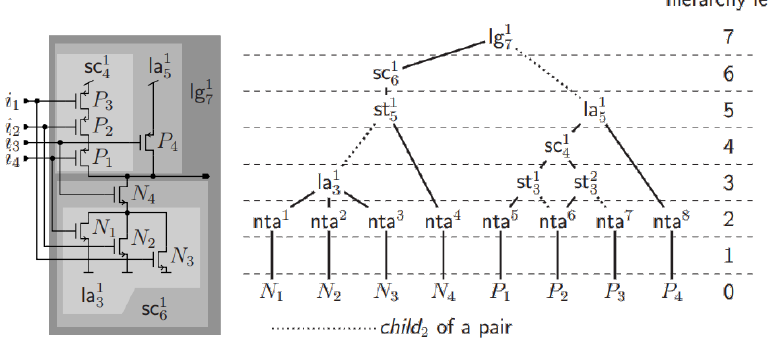
Figure 4. Hierarchical recognized structures for the circuit [44].